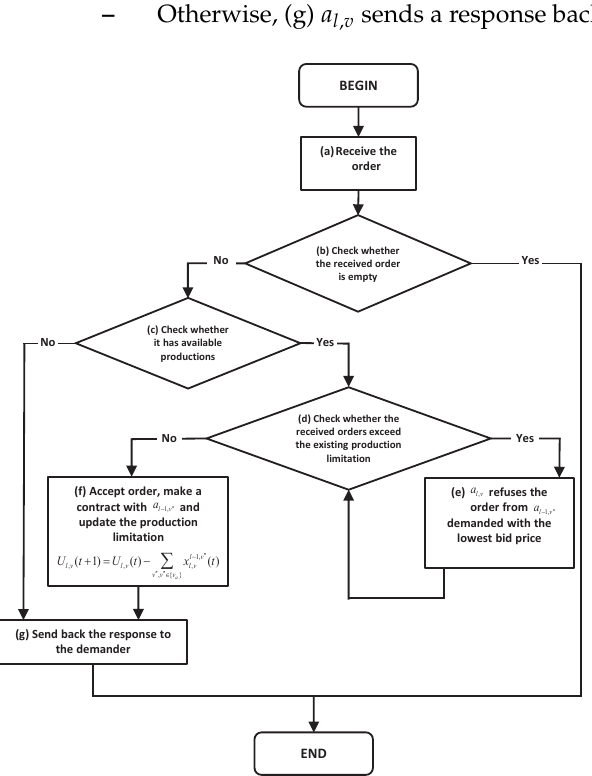
Figure 5. The process of receiving orders and choosing